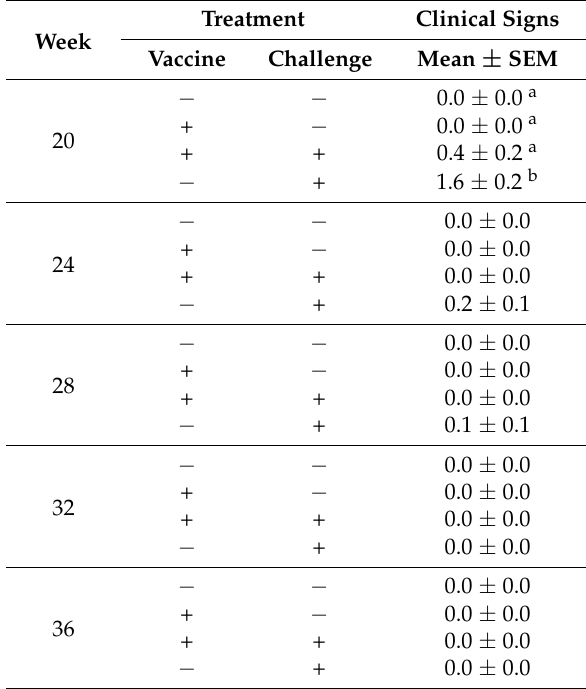
Table 4. Clinical signs measured 5 days following NDV B1 challenge. Letters (a–b) indicate significant differences among vaccine and challenge groups for each week ( p < 0.05).